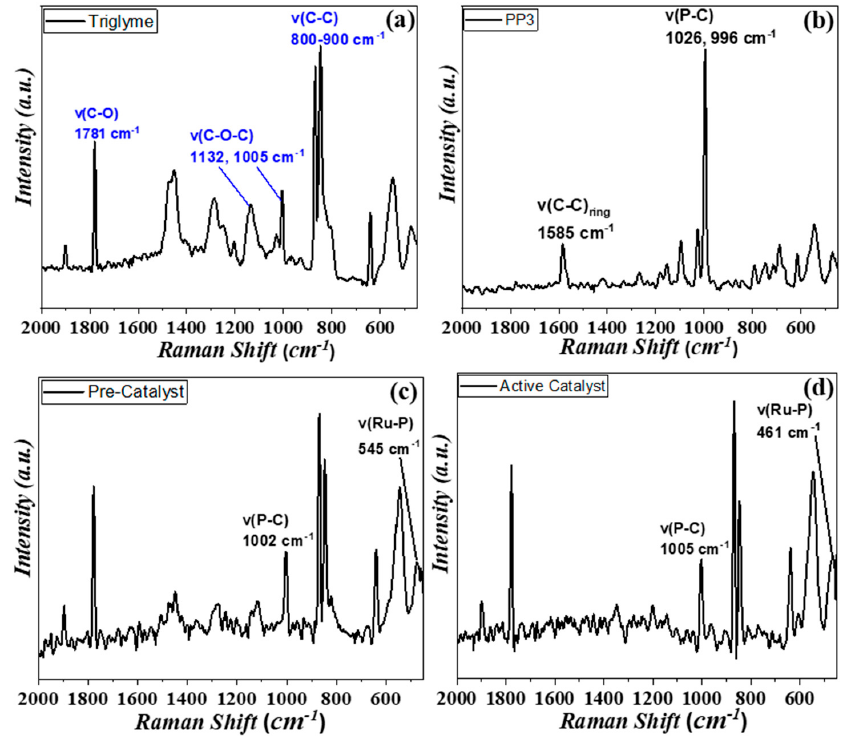
Figure 3 . Raman spectra of ( a ) tri-glyme (solvent), ( b ) phosphine ligand (PP3), ( c ) (Ru/PP3) catalyst in tri-glyme and ( d ) catalytic reaction ([Ru/PP3]/FA/KOH in tri-glyme: water solution).